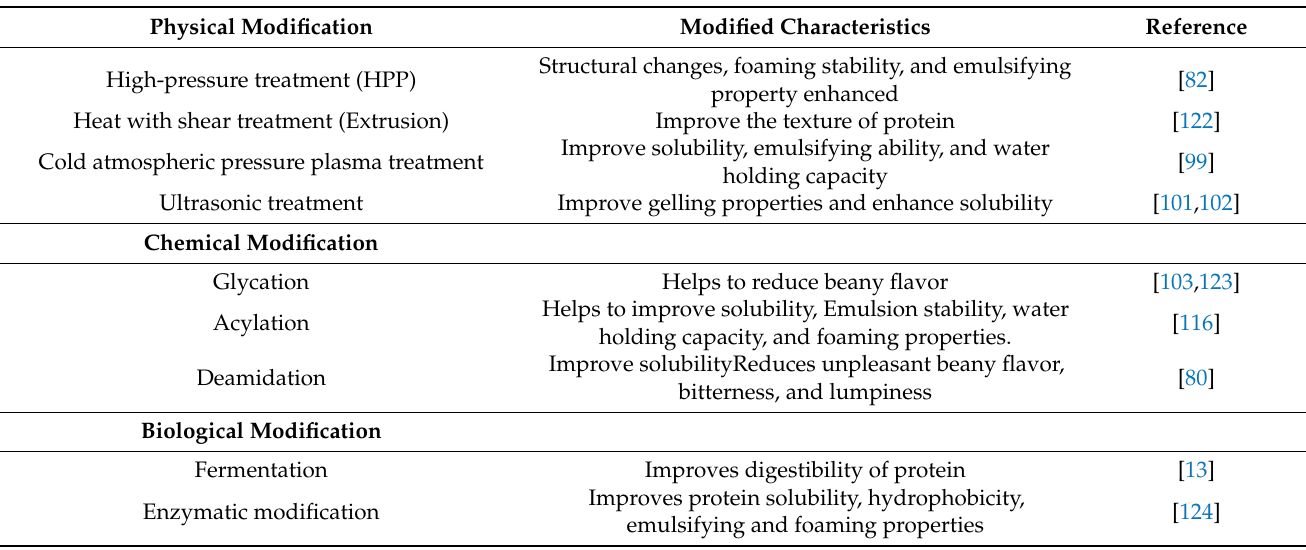
Table 4. Different modification methods and their characteristics.